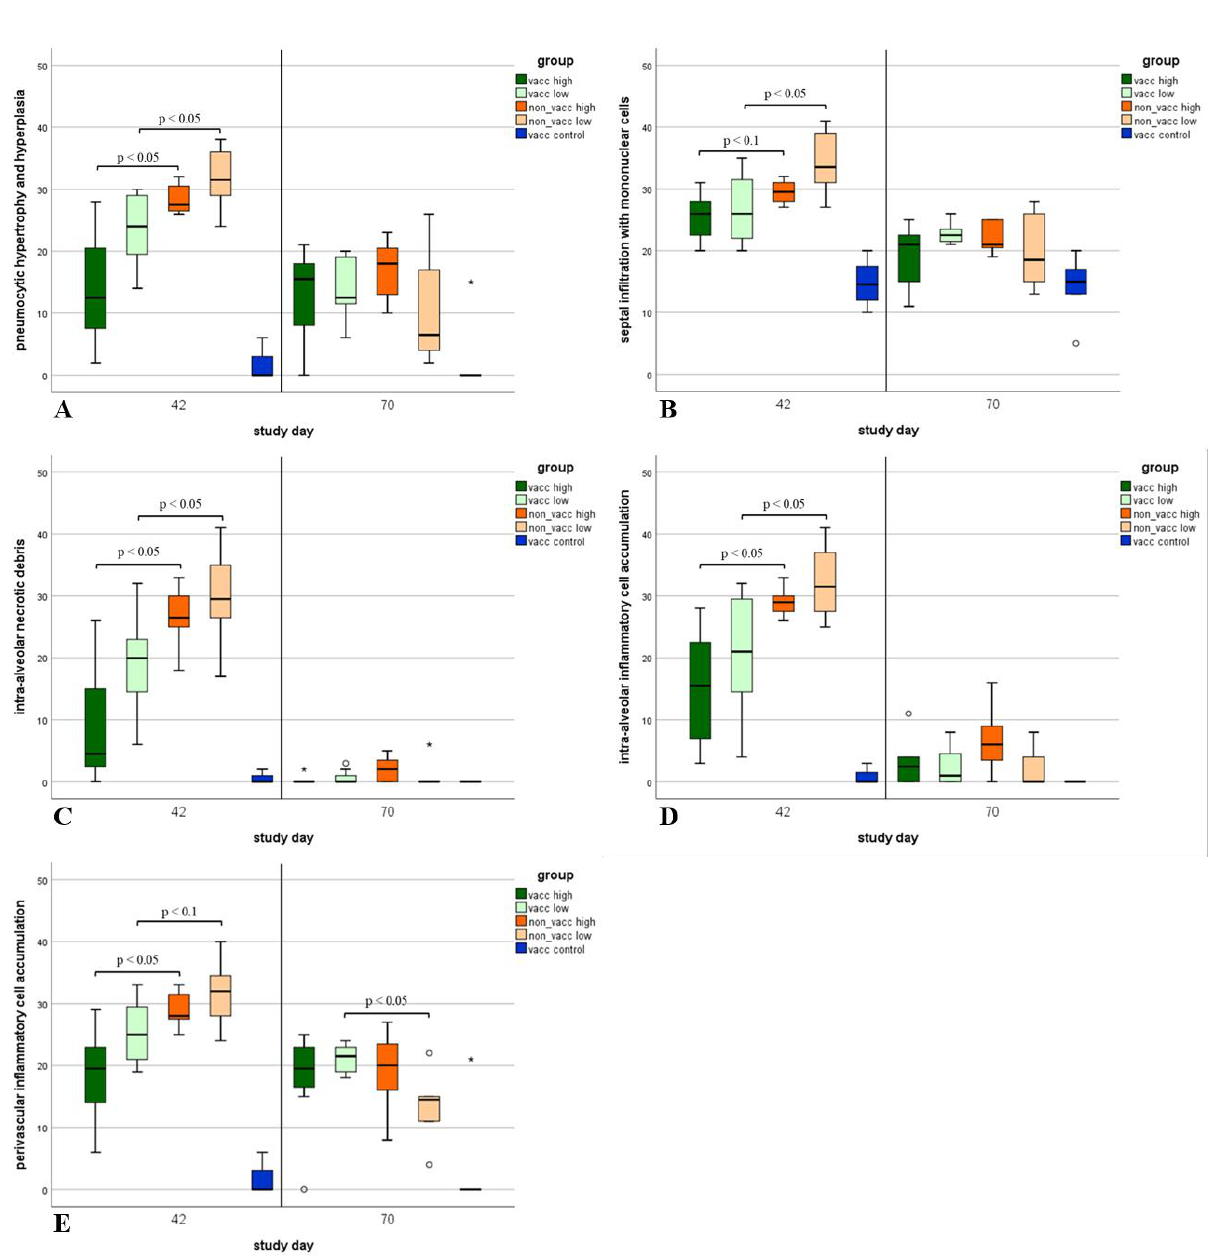
Figure 9. Histologic lung lesions. Histologic lung lesions of animals necropsied on either study day 42 (first necropsy) or study day 70 (second necropsy) in each group (vacc high: vaccinated, high dose [10 5 TCID 50 /dose] infected; vacc low: vaccinated, low dose [10 3 TCID 50 /dose] infected; non-vacc high: non-vaccinated, high dose infected; non-vacc low: non-vaccinated, low dose infected; vacc control: vaccinated, non-infected). All seven lung lobes from each piglet were scored histologically for severity and extension (scored as 0: no lesion; 1: mild; 2: moderate; or 3: severe) of the following five lesions: pneumocytic hypertrophy and hyperplasia ( A ), septal infiltration with mononuclear cells ( B ), intra-alveolar necrotic debris ( C ), intra-alveolar inflammatory cell accumulation ( D ), and perivascular inflammatory cell accumulation ( E ). Maximum score was 42 per lesion per piglet. Boxplots show 25th and 75th percentiles and median values, and whiskers show minimum and maximum values within 1.5 × interquartile range (IQR). Outliers are values with more than 1.5 × IQR (indicated using circles °), and extreme values are values with more than 3 × IQR (indicated using asterisks *). p -values < 0.1 are indicated using brackets.